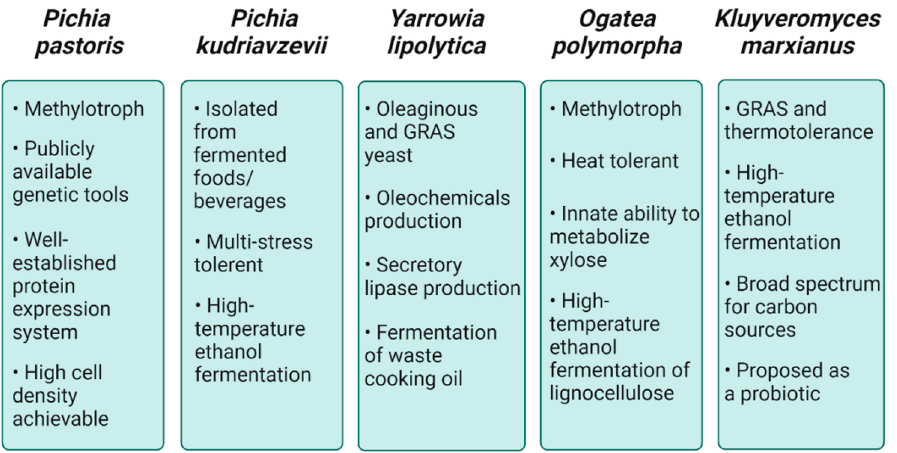
Figure 1. Properties and industrial values of promising NCYs.